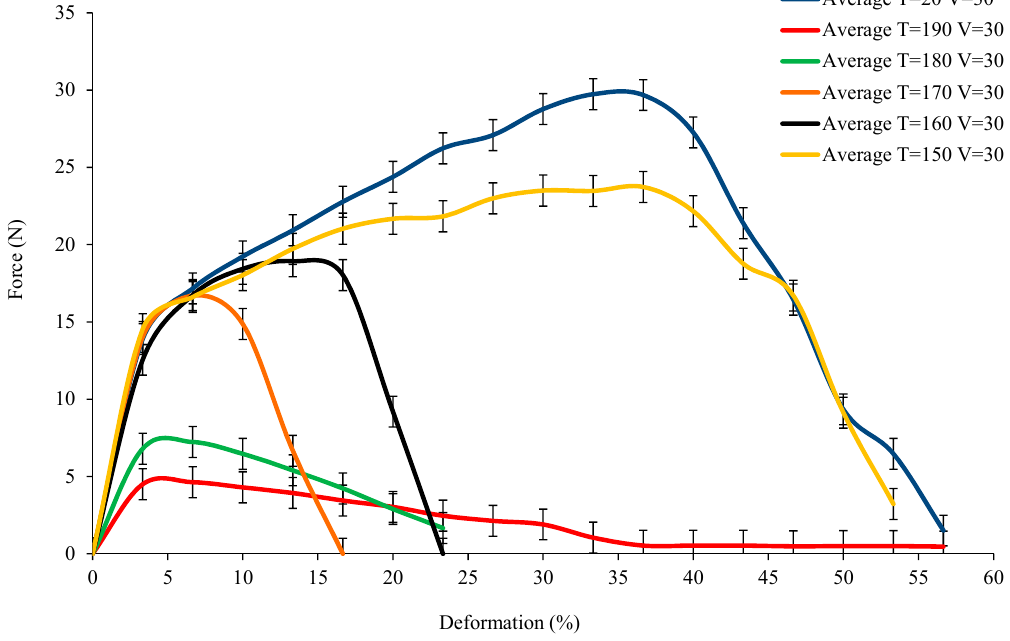
Figure 6. The load vs. deformation for single flax/PA12 yarn under variation of temperature.